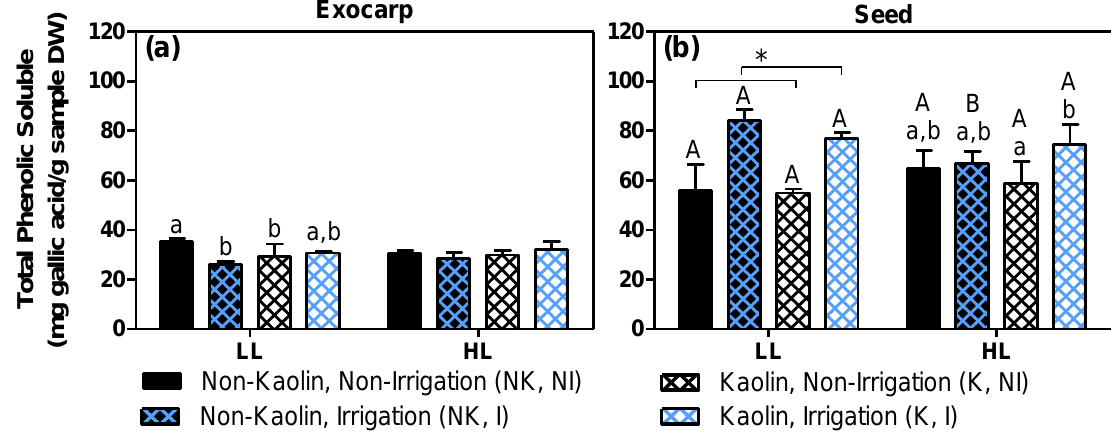
Figure 10. Total phenolic contents (mg gallic acid/g sample DW) in exocarps ( a ) and seeds ( b ) from mature stage berries. Growth conditions and treatments are the same as in Figure 8. Statistical notations above the bars: the capital letters refer to differences between the two light microclimates within the same treatment, while the lowercase letters refer to differences between treatment combinations within the same light microclimate (bars with no or a common letter indicate no significant differences; two-way ANOVA, p ≤ 0.05). Notation with an asterisk means that only one factor was significant